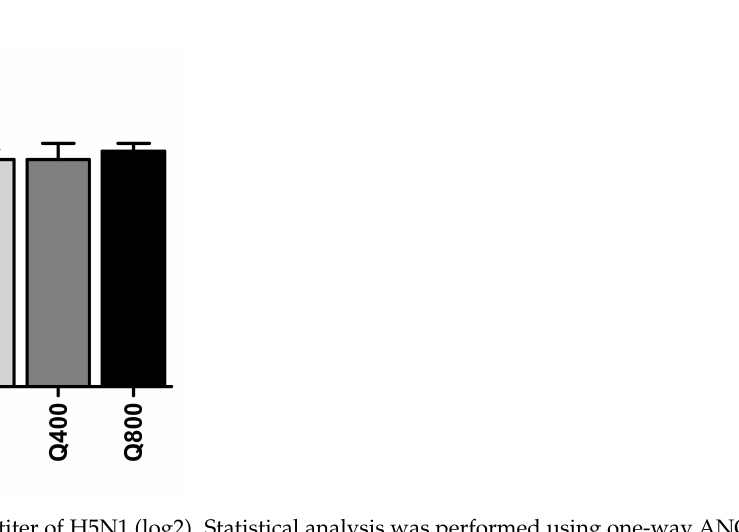
Figure 2. Antibody titer of H5N1 (log2). Statistical analysis was performed using one-way ANOVA and Tukey’s post hoc test for multiple comparisons. Q200, birds fed 200 ppm. Q400, birds fed 400 ppm. Q800, birds fed 800 ppm.